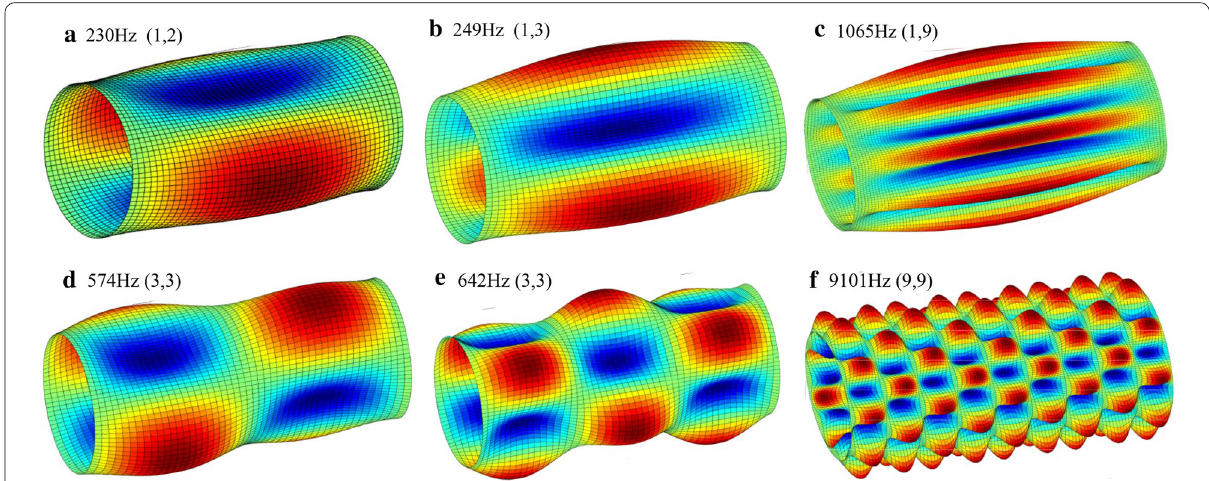
Figure 10 The modal shapes of pressure pipe with simply